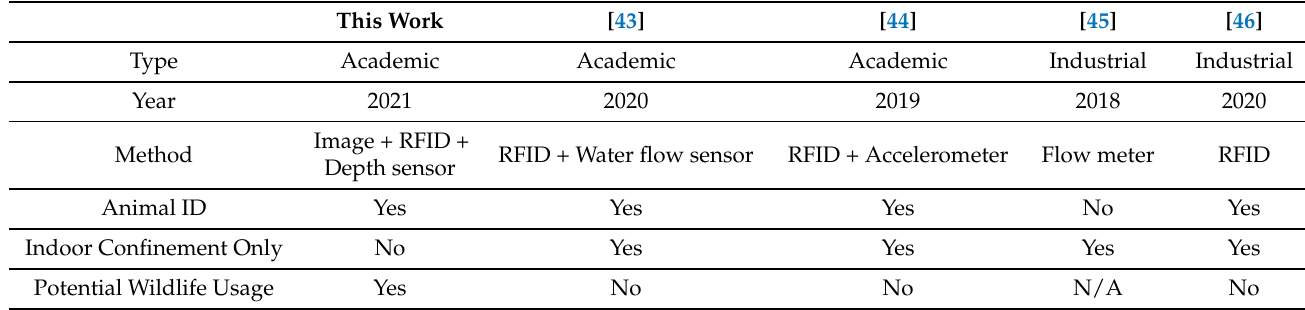
Table 2. Comparison between this work and recently published